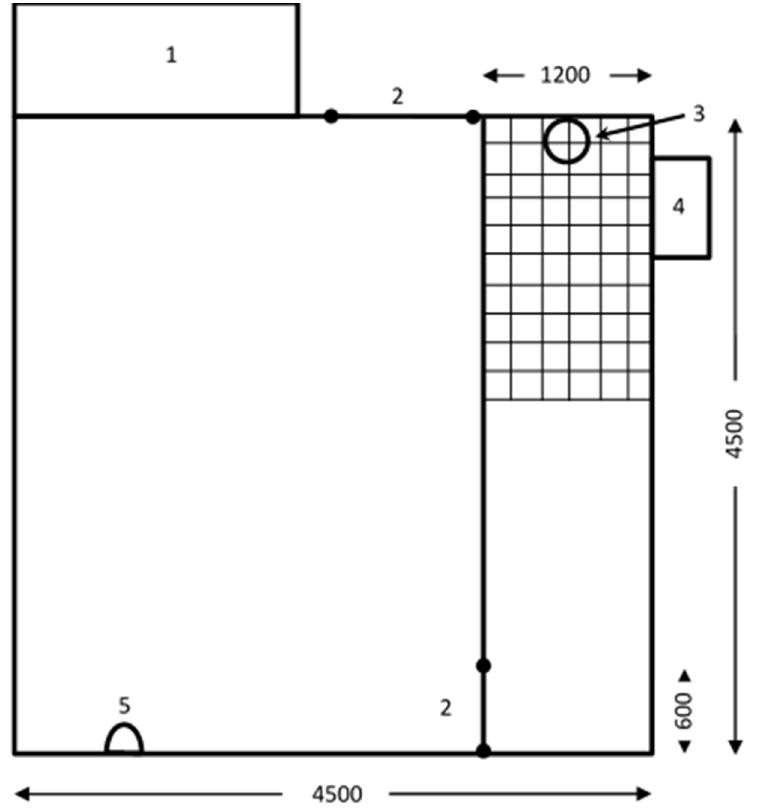
Figure 1. Individual pen for the calf and the mother of the RS group. 1 —Concrete feed trough for cow; 2 —gate; 3 —starter mixture feeder; 4 —hanging hay feeder; 5 —cow cow; 2 —gate; 3 —starter mixture feeder; 4 —hanging hay feeder; 5 —cow drinker.